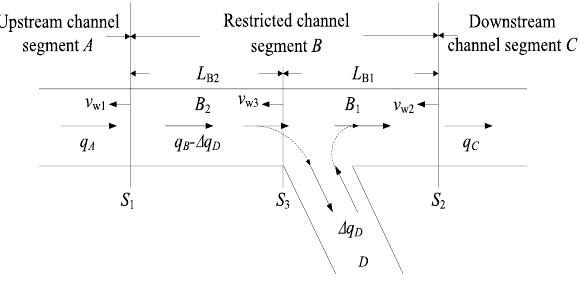
Fig. 6 The unclosed restricted